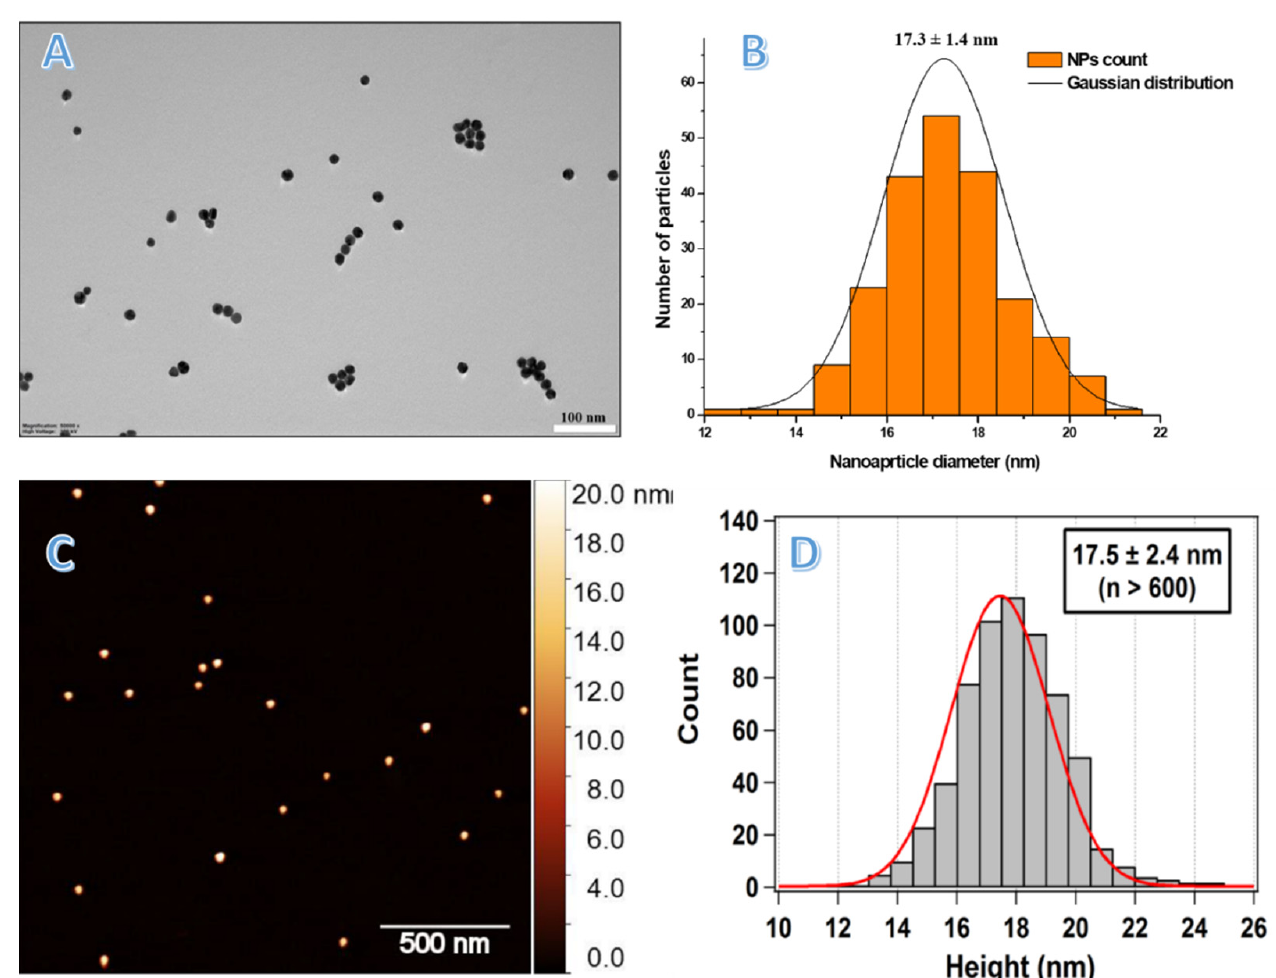
Figure 2 . ( A,B ) A TEM micrograph of synthesized AuNPs with a scale bar of 100 nm, and the statistical analysis indicating nanoparticle size distribution evaluated for over 250 nanoparticles. ( C , D ) A 2 × 2 µ m 2 AFM non-contact mode image of AuNPs deposited on poly-L-ornithine-coated mica, and its corresponding statistical analysis.